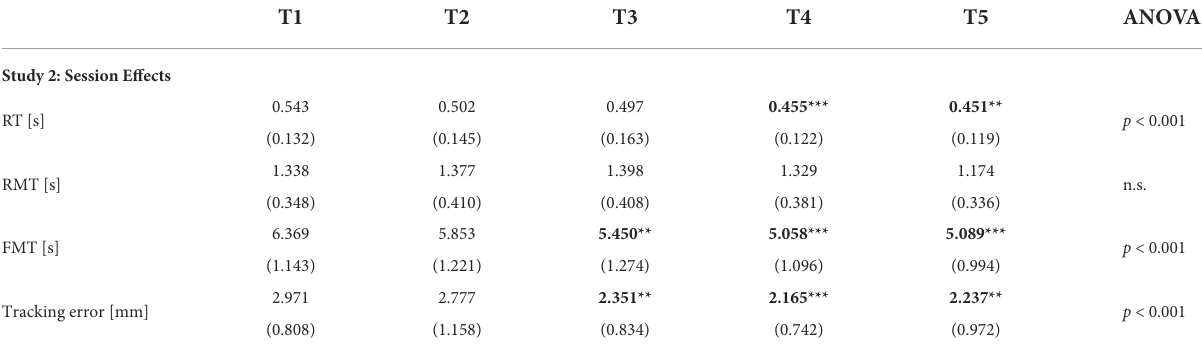
TABLE 4 Session effects on performance measures: Means, SD (in parentheses), and rmANOVA main effects. T1 T2 T3